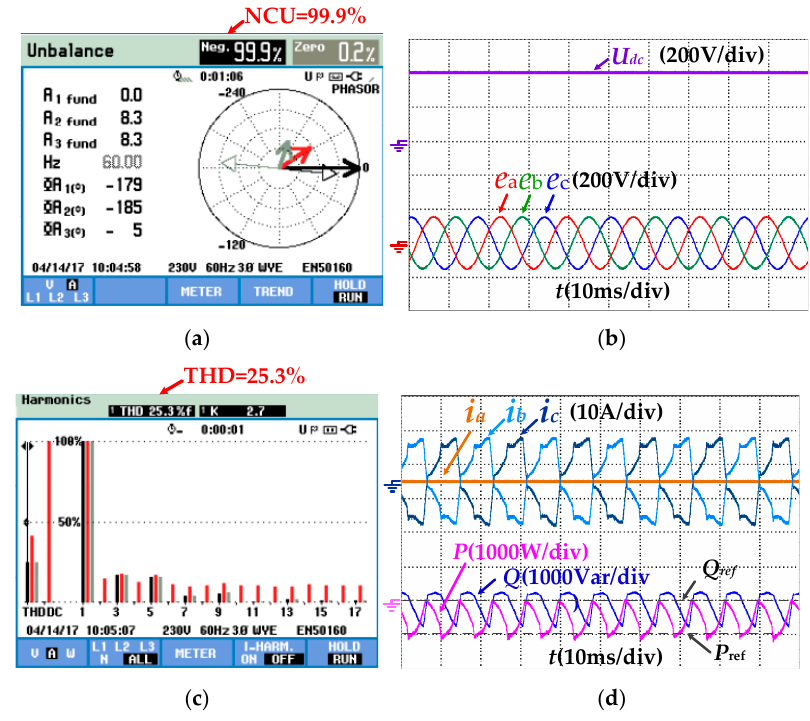
Figure 14. Experimental results of BVSC in rectifier mode with leg faults of phase a ( a ) negative current unbalance; ( b ) voltage waveform; ( c ) harmonics spectrum; ( d ) current and power waveform.